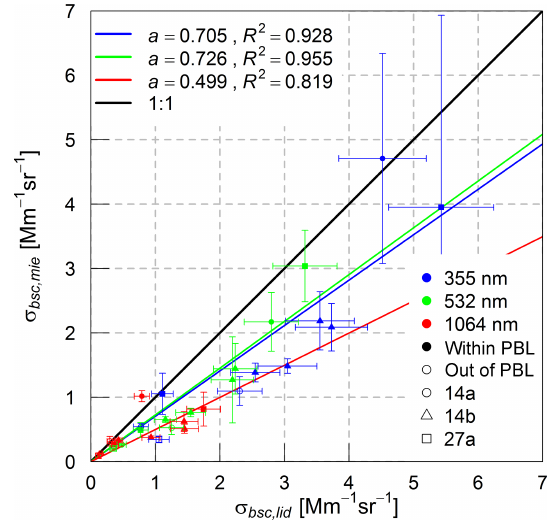
Figure 14. Scatterplot of the airborne-based ( σ bsc, mie ) and the lidar-based ( σ bsc, lid ) particle light backscatter coefficients for all horizontal legs during the investigated days for wavelengths λ = 355 (blue), 532 (green), and 1064nm (red). The error bars represent the assumed 15% error for the lidar measurements and 3 times the standard deviation of the mean of the result of the Mie calculations. The colored lines represent the linear correlation of both parame- ters, with a the slope of the fit and R 2 the correlation coefficient. The black one is the 1 : 1 line. Filled symbols indicate data points determined within the planetary boundary layer, whereas empty symbols indicate data points above. Circles represent data points de- termined during flight 14a; triangles indicate flight 14b and squares 27a.